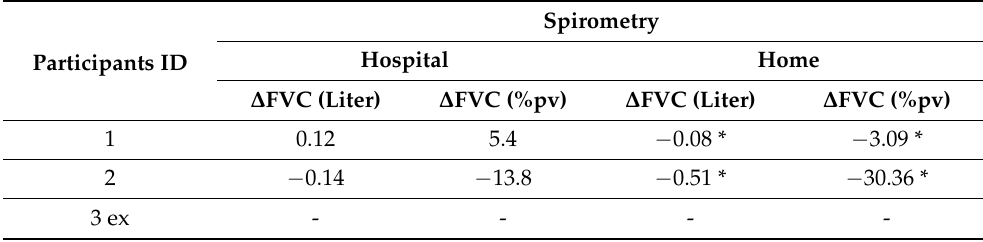
Table 4. Differences of forced vital capacity (FVC) values between two control points (start and 90 days follow-up) in hospital spirometry and home spirometry for individual